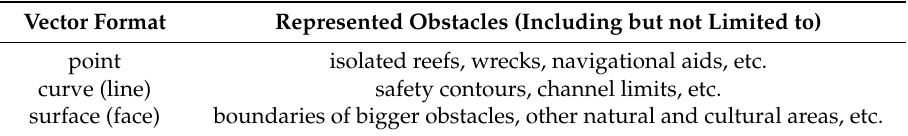
Table 2. Spatial vector data in the electronic navigational chart